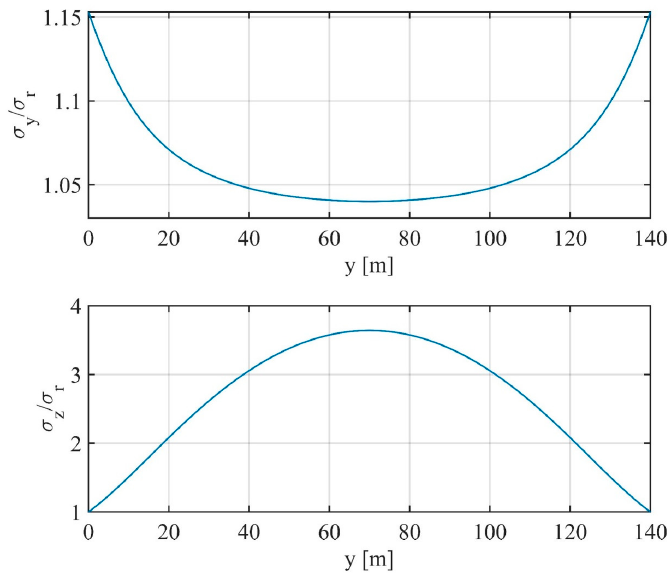
Figure 5. Theoretical uncertainty calculated using Equation (3).